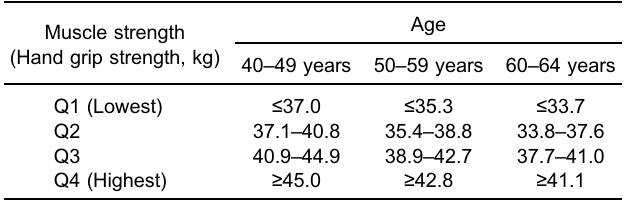
Table 1. Age-speci fi c cut-off values for muscle strength based on